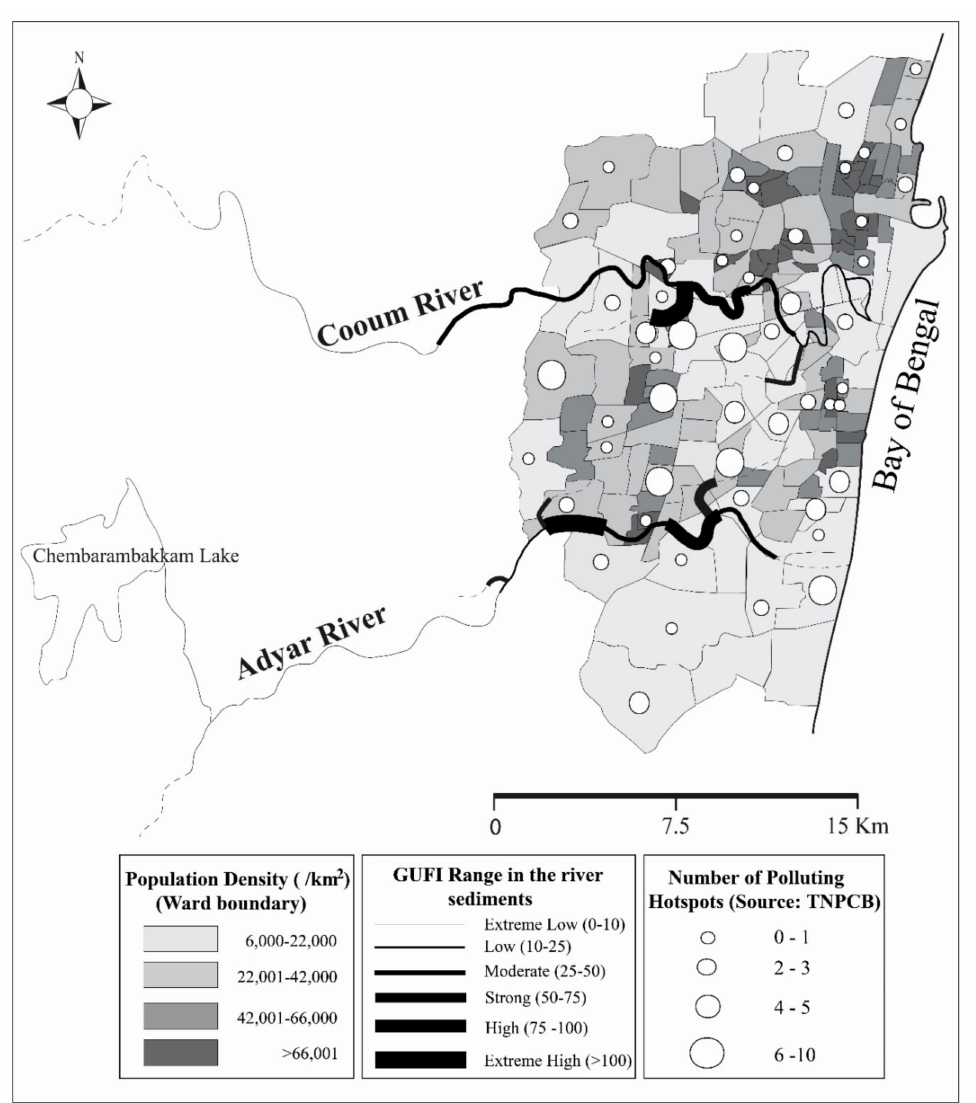
Figure 4. Longitudinal variation of the Geochemical Urban Footprint Index (GUFI) associated with population density and polluting hotspots at the ward scale in